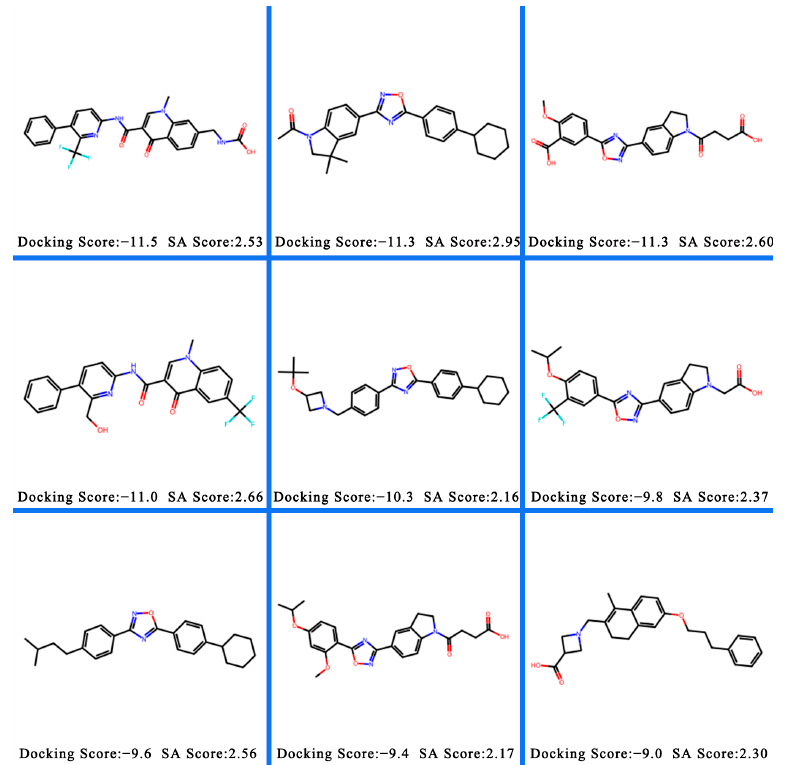
Figure A1. Distributions of the docking scores of the generated molecules for EGFR, HTR1A and S1PR1.